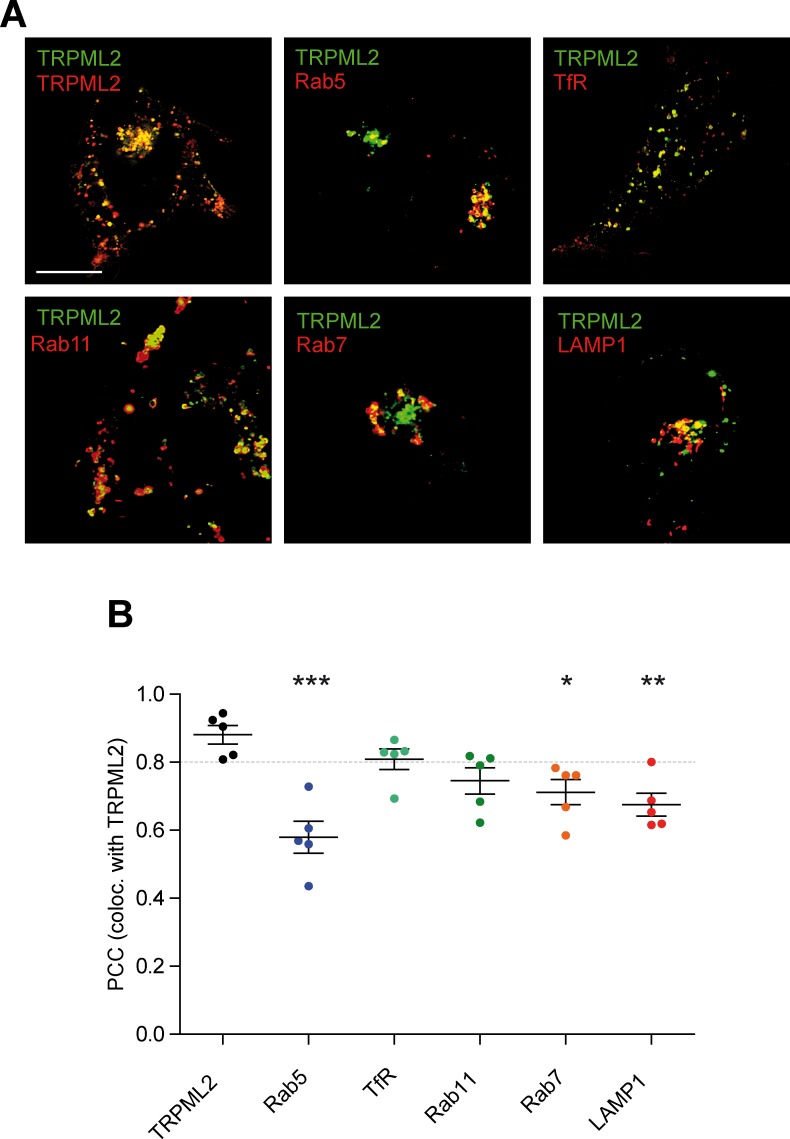
Co-transfection of HEK293 cells with fluorescently labelled TRPML2 and vesicle-specific markers of the endolysosomal system.(A) Shown are representative images of TRPML2 (green) transiently cotransfected with either TRPML2 (red) or markers of the endolysosomal system (red): Rab5 (early endosomes), TfR (early/recycling endosomes), Rab11 (recycling endosomes), Rab7 (late endosomes), or LAMP1 (late endosomes/lysosomes). Scale bar (identical for all images)=10 μm. (B) TRPML2 colocalisation quantification. Pearson’s Correlation Coefficients were calculated by marking and isolating single cells in ImageJ, using the ImageJ plugin ‘JACoP’ to quantify the localization correlation. Individual PCC values are plotted alongside overall mean values ± SEM of five individual cells. Colocalization of TRPML2 did not significantly differ from TRPML2 (0.880 ± 0.028) with either TfR (0.809 ± 0.030) or Rab11 (0.745 ± 0.039), while it appeared to colocalize significantly less with Rab5 (0.579 ± 0.047), Rab7 (0.712 ± 0.037), and LAMP1 (0.675 ± 0.034). * indicates p<0.05, ** indicates p<0.01, *** indicates p<0.001, one-way ANOVA test followed by Dunnett’s post-hoc test comparing against TRPML2/TRPML2.